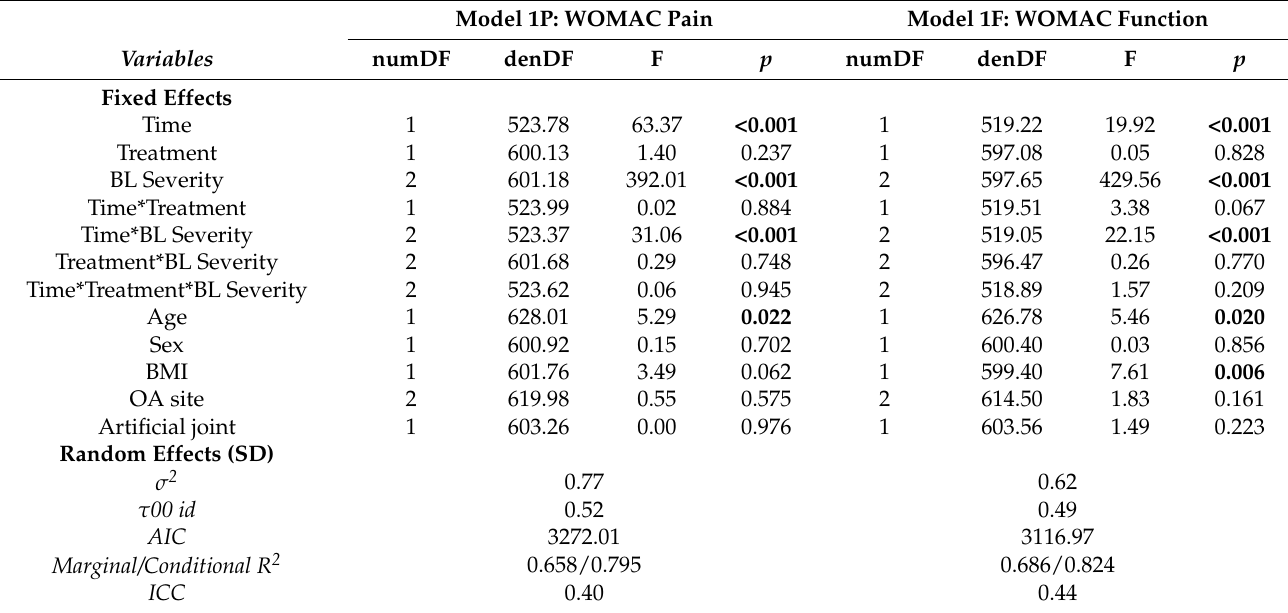
Table 4. Neither of the two LMMs revealed significant time * treatment*baseline disease severity interactions ( Model 1p : p = 0.945, Model 1f : p = 0.209). Also, the time*treatment interaction for pain was non-significant ( Model 1p : p = 0.884) and failed to reach statistical significance for WOMAC function ( Model 1f : p = 0.067). The time*baseline disease severity interactions were found to be significant for both models ( p < 0.001). Table 4. Results for the primary outcomes WOMAC pain and function of the linear mixed models. Model 1P: WOMAC Pain Model 1F: WOMAC Function